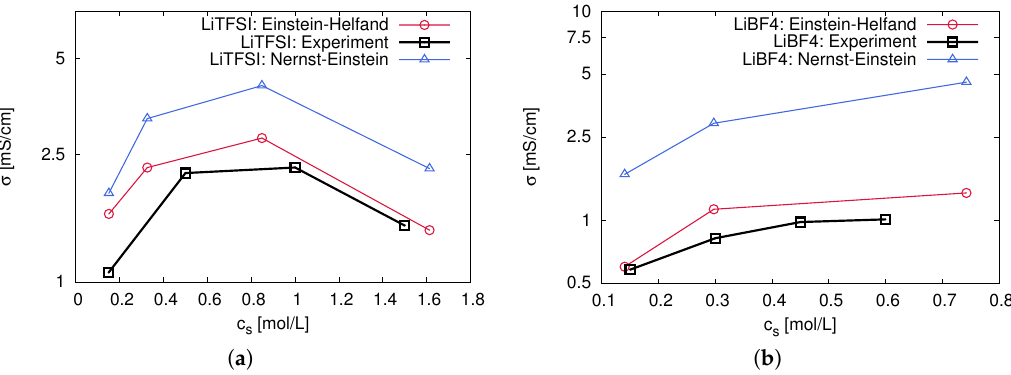
Figure 5. Ideal Nernst–Einstein (blue lines with triangles) and effective Einstein–Helfand ionic conductivities (red lines with circles) for varying concentrations of LiTFSI ( a ) and LiBF 4 ( b ) in adiponitrile. Experimental results are shown as squares with black lines. The solid lines are guides for the eyes. Figure reproduced from Ref.